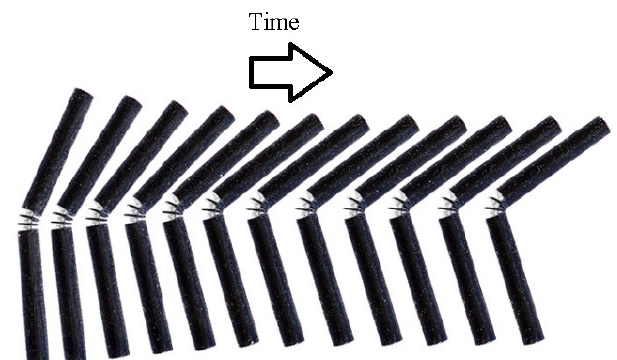
Figure 6. Centrifugal pump and its bearings adapted from Daigle et al. (2012).